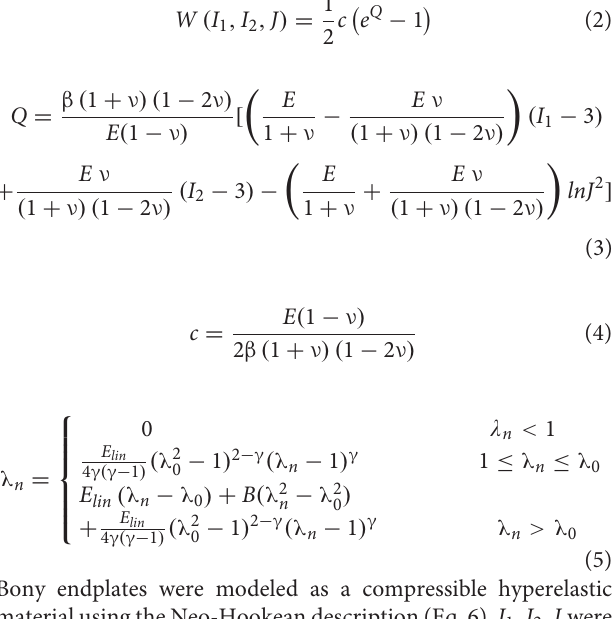
experimental data ( Table 1 –solid phase: E lin , γ , and λ 0 ). For all material properties, data from healthy human discs was used when bovine properties were not available, due to similarities in tissue properties ( Table 1 –“ ∗